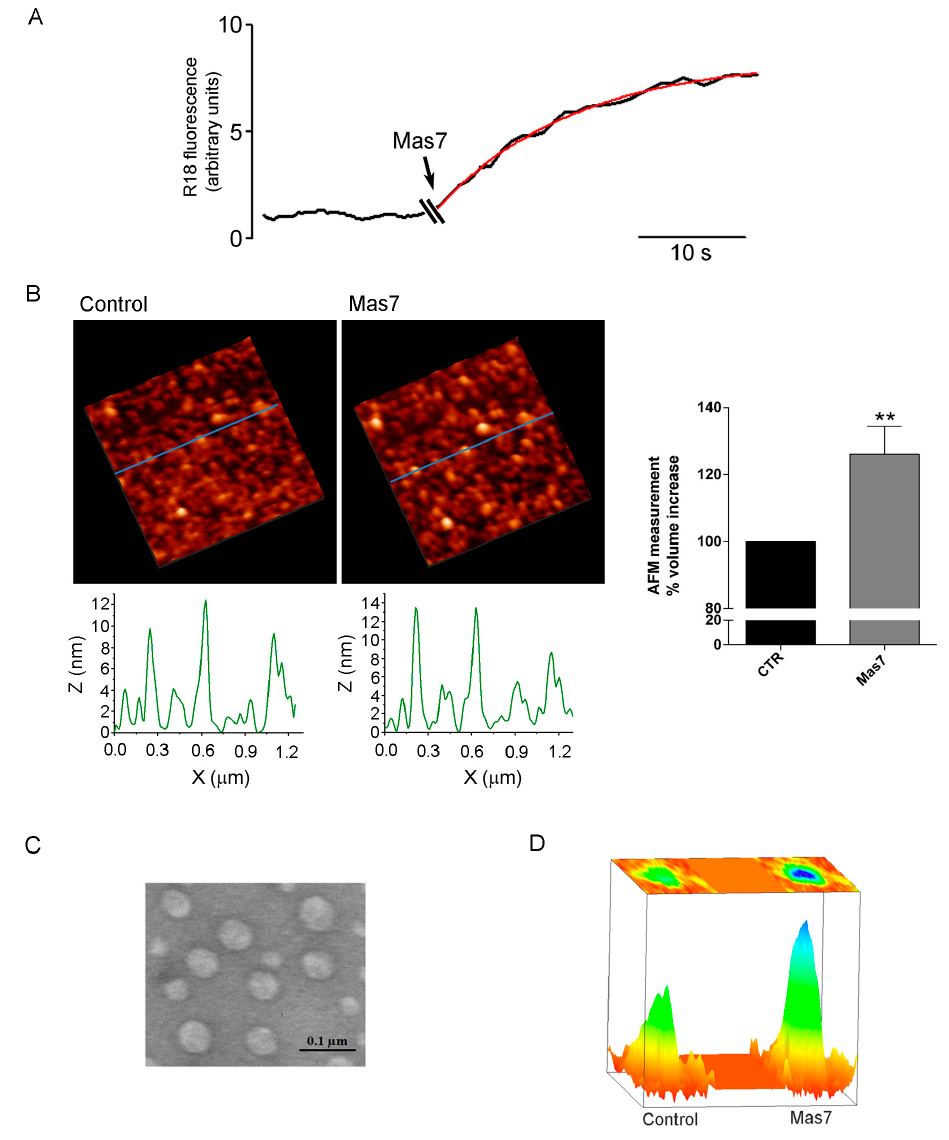
Figure 3. Activation of Gi protein, located in AQP2 vesicles, promotes vesicles swelling. ( A ) Time course of AQP2 vesicles swelling assay monitored using the fluorescent lipid probe R18 loaded at self-quenching concentration. Vesicles plated on multiwells were labelled with R18 and exposed to Mas7 (arrow) in the absence of an osmotic gradient. The swelling process was depicted by an increase in the fluorescent emission signal with a maximal signal achieved within the first 30 s. The exponential fit is shown in red. No swelling was observed in the absence of Mas7 ( B ) 3D AFM images and section analysis of isolated AQP2 vesicles under basal conditions and after exposure to Mas7. Size changes of each single vesicle were monitored and processed using an algorithm specifically elaborated for this purpose (see Experimental Procedures for details). Statistical analysis of vesicle size changes, on the right, shows that exposure of AQP2 vesicles to Mas7 in the absence of an osmotic gradient resulted in a significant volume increase with respect to resting condition. Data (means ± S.E.Ms) were analysed by Student’s t test. ** p = 0.0065. ( C ) Electron microscopy of isolated vesicles showing a pretty homogeneous vesicle size of 60 nm diameter in average. ( D ) Representative example of reconstructed 3D AFM image of the same vesicle before and after exposure to Mas7 depicting the volume increase with color-coded height information in a three-dimensional perspective. On top is reported the projection on the x-y plane of the three-dimensional AFM vesicle image. This 3D Colormap surface with projection, was obtained by plotting the data twice: once as a 3D surface plot and a second time as a flat